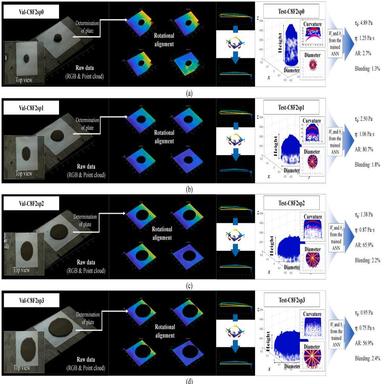
Application of proposed method for a rapid characterization of fresh properties: (a) Val-C8F2sp0, (b) Val-C8F2sp1, (c) Val-C8F2sp2, and (d) Val-C8F2sp3.